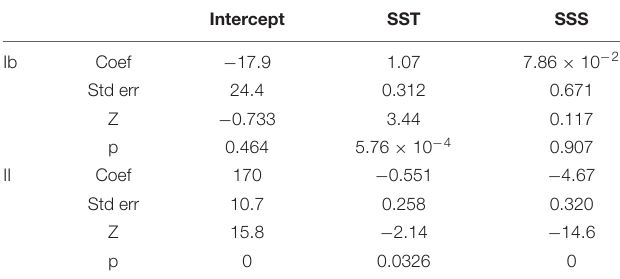
TABLE 7 | Results of multinomial regression for cox haplogroup (rel. to haplogroup I) against direct measures of SST and SSS for strains from near the 30 ◦ S coastal